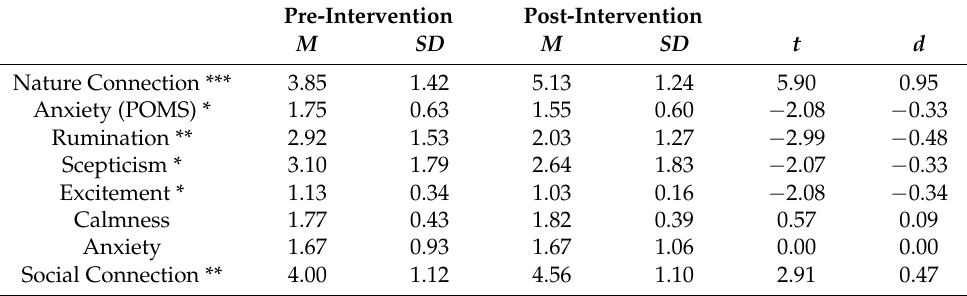
Table 1. Changes in outcome variables between baseline and